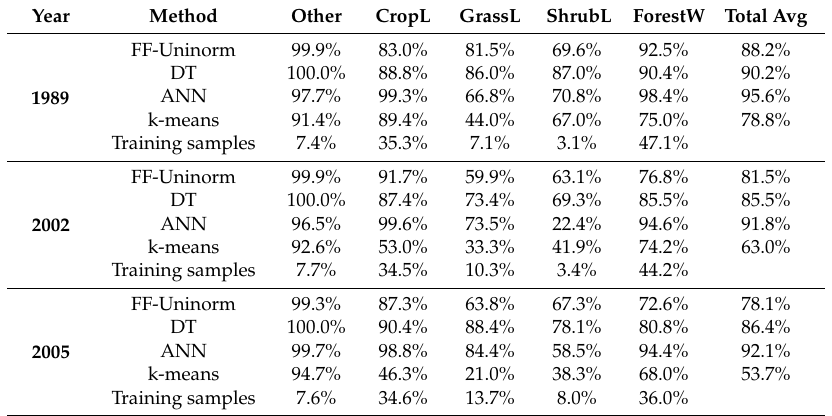
Table 2. Accuracy of classifying the training set with FF-Uninorm, DT, ANN and k-means.